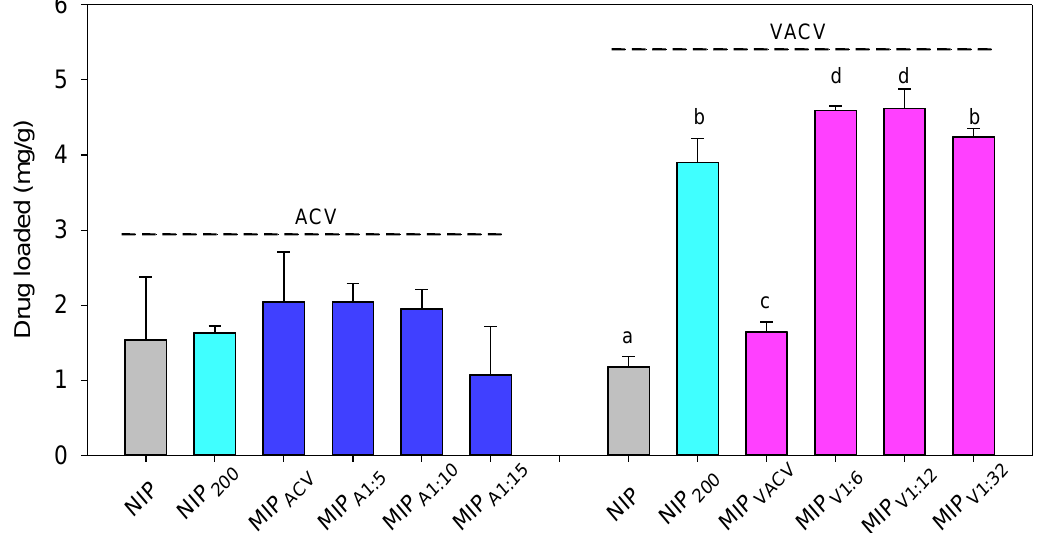
Figure 4. Amounts of ACV and VACV loaded by the hydrogels after 4 days of soaking in the drug solution (0.3 mg/mL). Different letters indicate statistically significant differences with a p -value < 0.05. On the X-axis, the hydrogel codes are the same as those in Table 1.